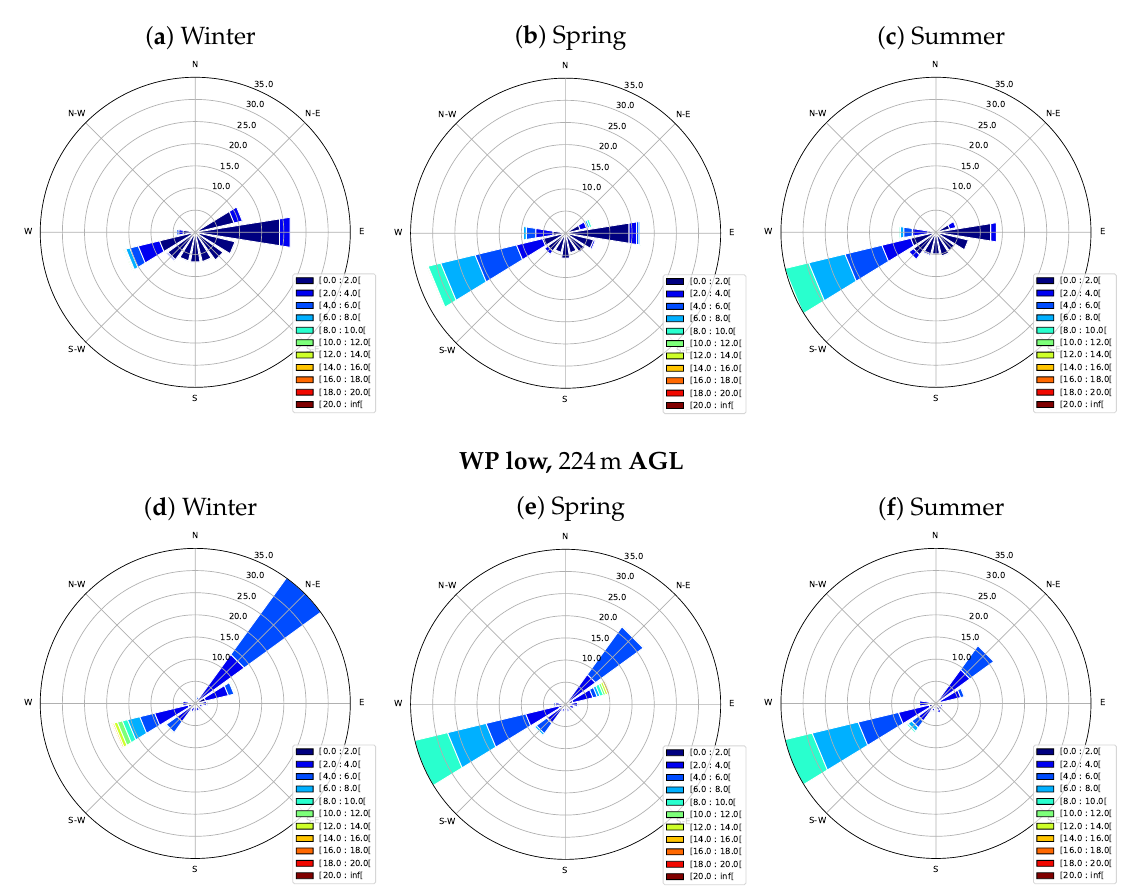
Figure 5. As in Figure 4, but for winter (December 1 to February 28), spring (March 1 to May 31), and summer (June 1 to July 17). Note that only the weather station and low-mode data are